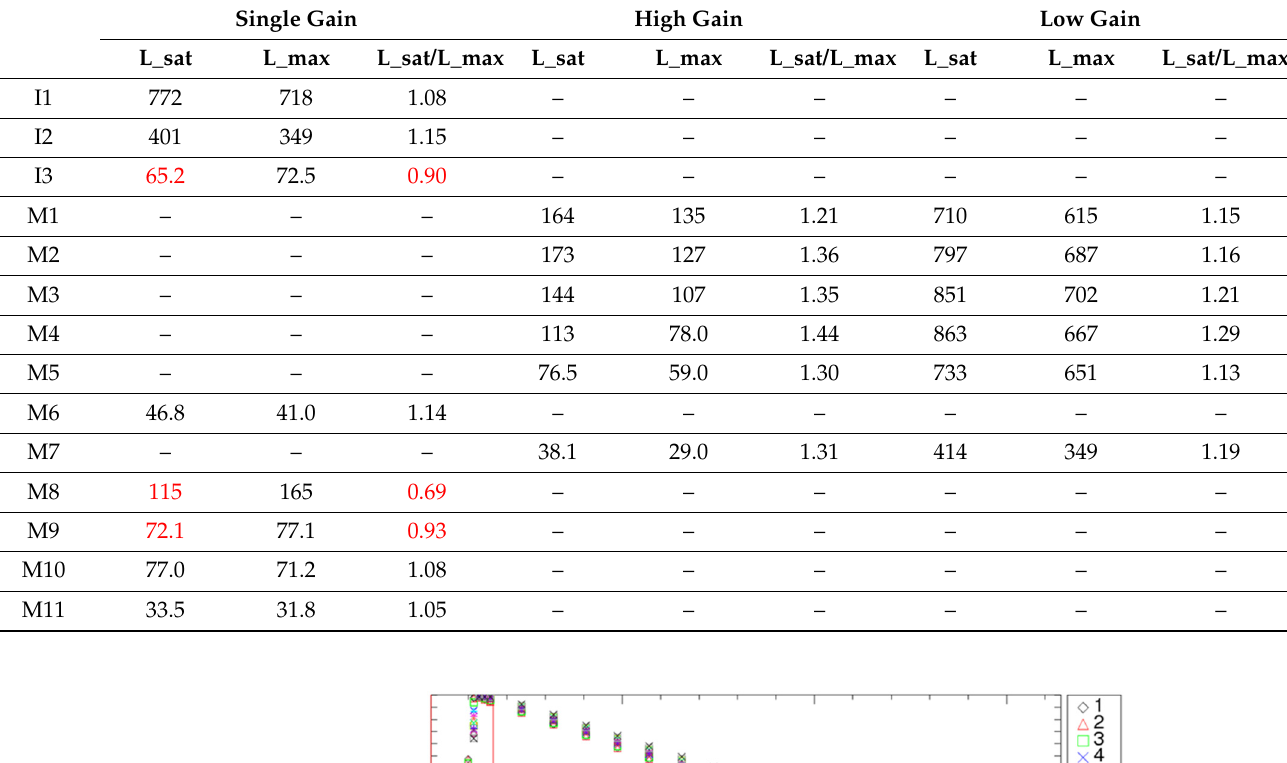
Table 2. Measured dynamic range performance for the reflective solar bands. Bands I3 and M8 fail the sensor specification, and band M9 shows just below the requirements but has impacts of water absorption in the analysis and most likely passes the requirements.